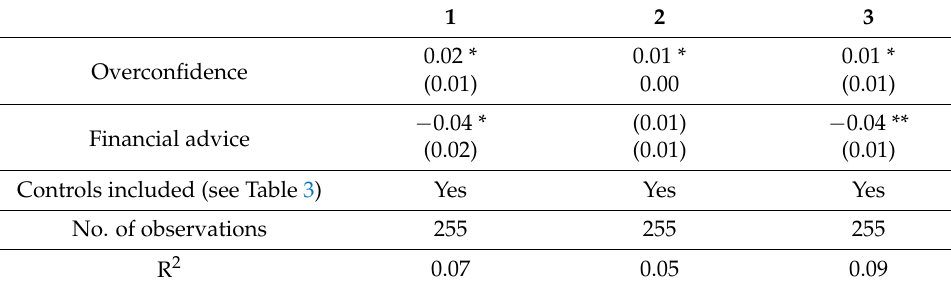
Table 5. Portfolio risk, overconfidence, and financial